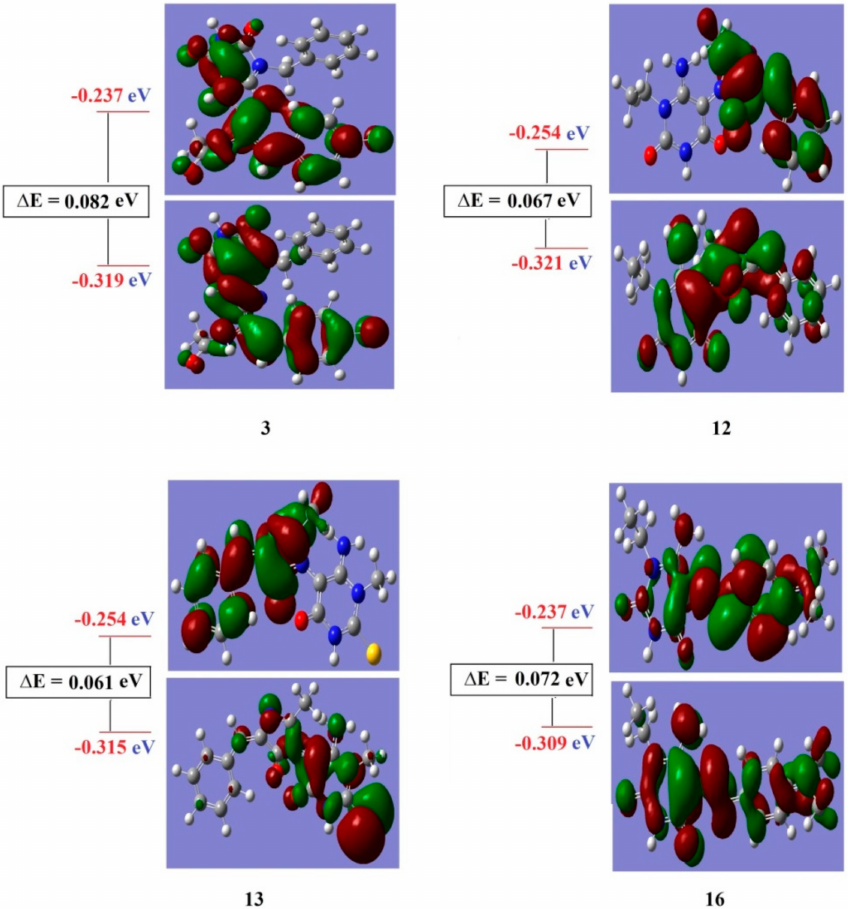
Figure 13. Molecular orbital surfaces and energy levels of all studied compounds, 3 , 12 , 13 and 16 by using DFT